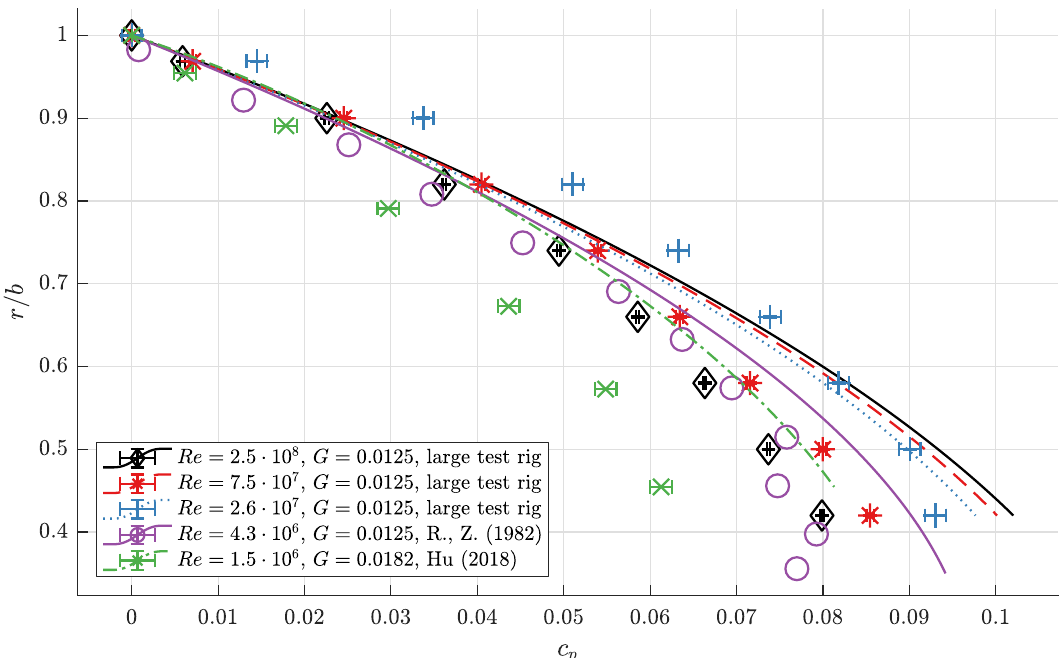
Figure 3. Radial pressure distribution c p ( r ) (see Equation (5)) at small cavity widths with closed cavities. The markers denote measurements; lines are predictions using the models proposed by Kurokawa and Sakuma [2]. r / b is the radial position relative to the discs’ outer radius. “Hu (2018)” refers to [10], and “R., Z. (1982)” to